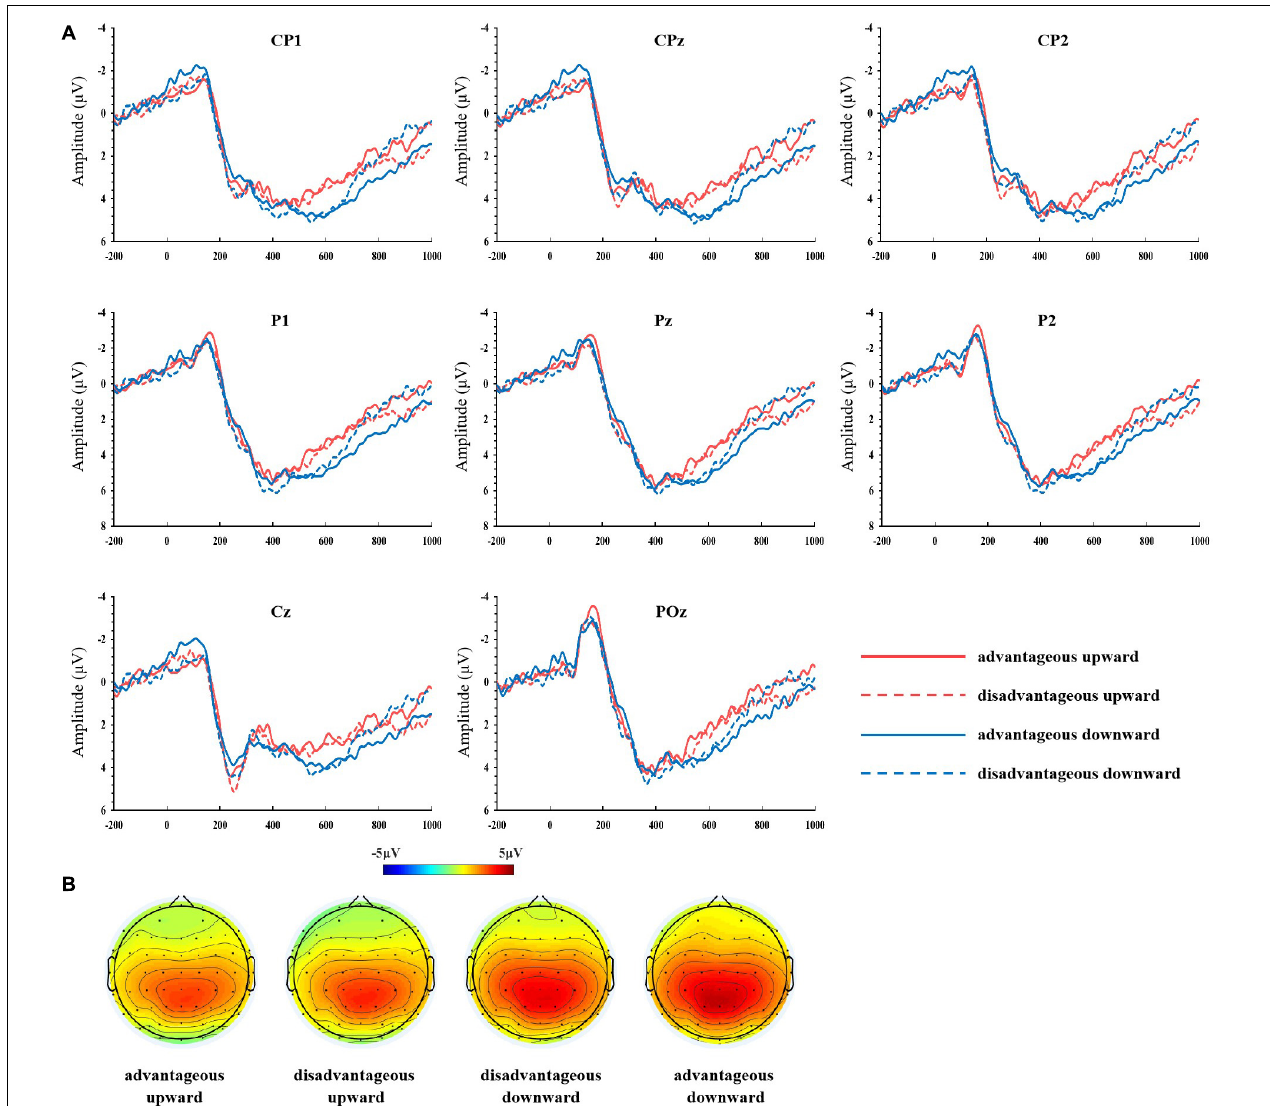
FIGURE 3 | (A) Grand-averaged ERPs at Cp1, Cpz, Cp2, P1, Pz, P2, Cz, and POz electrodes for late positive potential (LPP) with a comparison of the outcome under various feedback conditions. (B) Topographical voltage distributions of four conditions of interest in the time range of the LPP (500–800